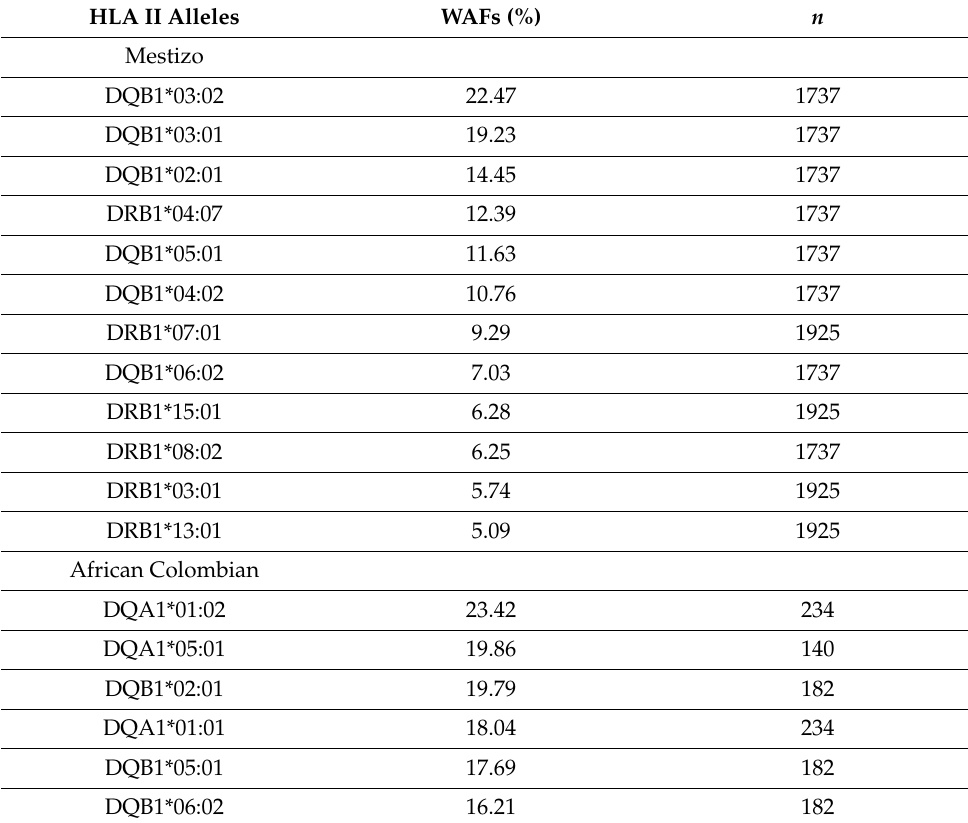
Table 7. HLA II alleles with high frequency (WAFs > 5%) in each of the three ethnicities included in this study for the Colombian